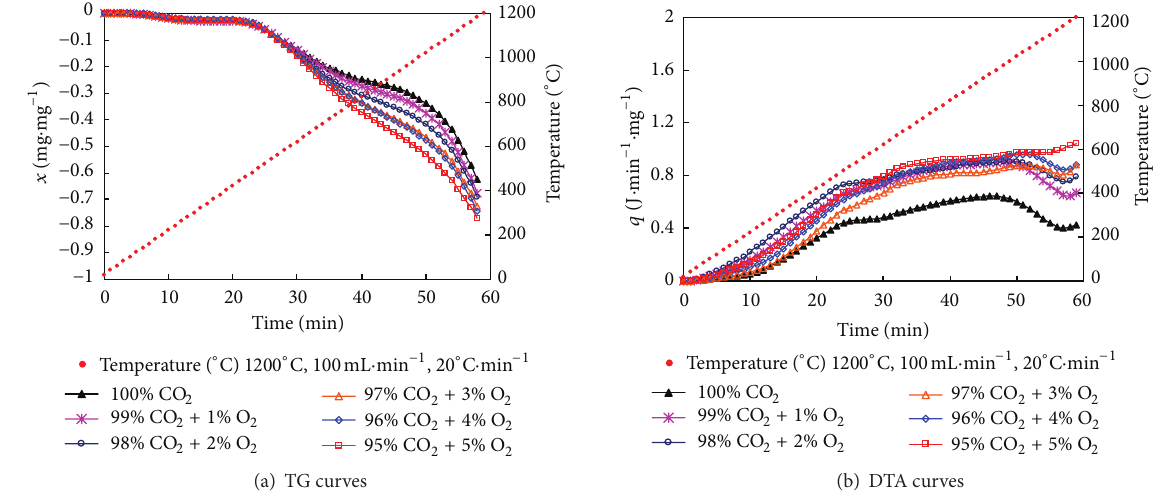
Figure 10: TG-DTA curves of different O 2 concentrations with a temperature of 1200 ∘